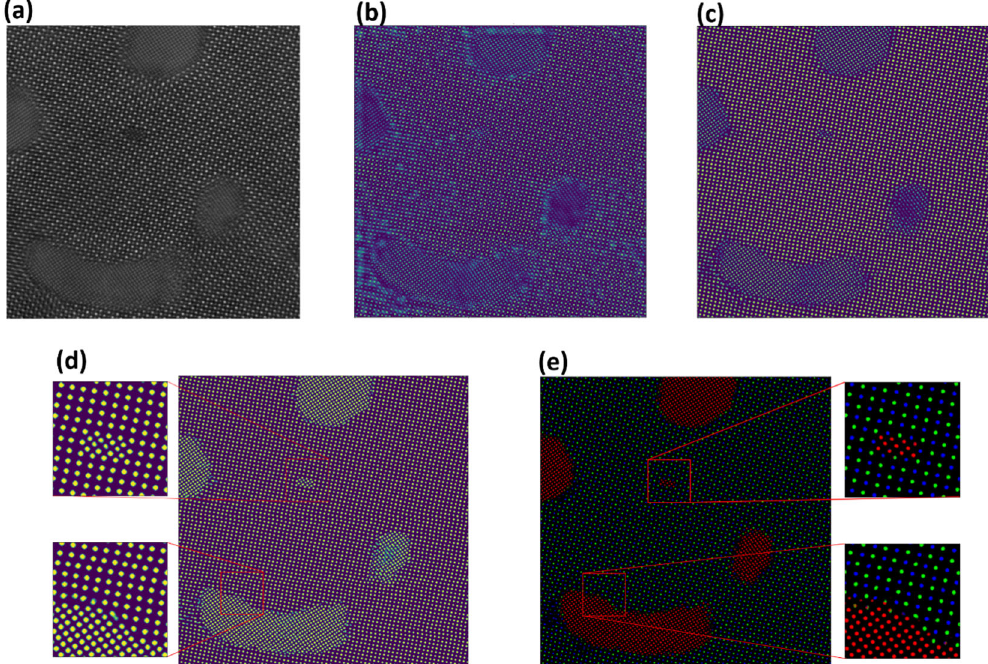
Fig. 6 Application of ELIT to a single image. a Experimental STEM image of NiO-LSMO. b Result (semantically segmented map) from ensemble of models trained on simulated data. c Prediction (semantically segmented map) after the fi rst ELIT re-training. d , e Predictions (semantically segmented maps) after the second ELIT retraining for a single class ( d ) and multiple classes ( e